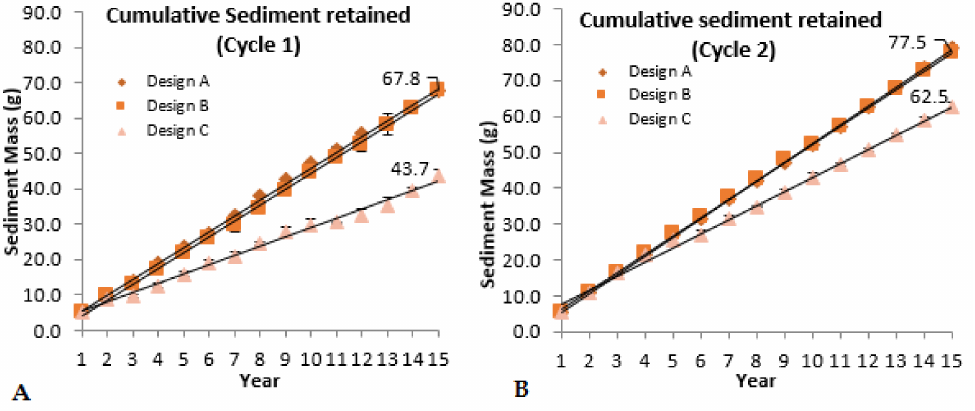
Figure 8. The cumulative sediment retention of permeable interlocking concrete pavers (PICPs) in ( A ) Cycle 1 and ( B ) Cycle